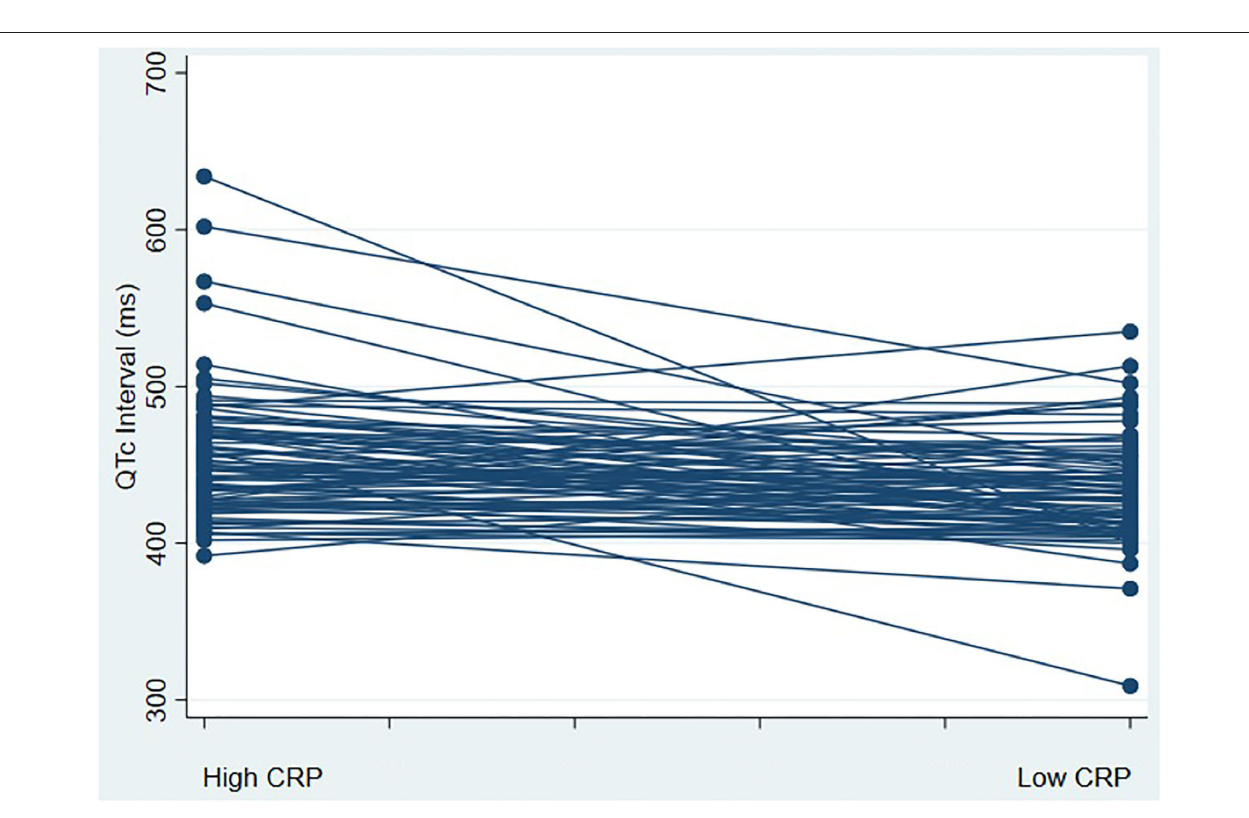
FIGURE 2 | corrected QT (QTc) interval change with a marked change in CRP values. This figure represents a spaghetti plot of QTc interval values comparing QTc intervals during high and low CRP states; 27 participants had an increase in QTc interval with a decrease in CRP levels (discordant), whereas 58 participants had a decrease in QTc interval with a reduction in CRP levels (concordant changes). Abbreviations: CRP, C-reactive protein; QTc, corrected QT